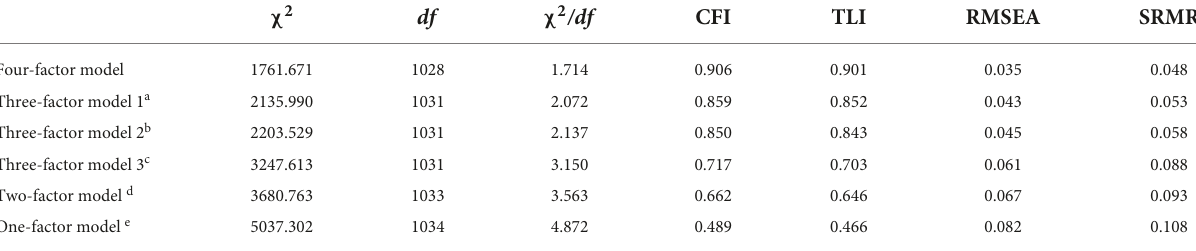
TABLE 2 Measurement model comparison.